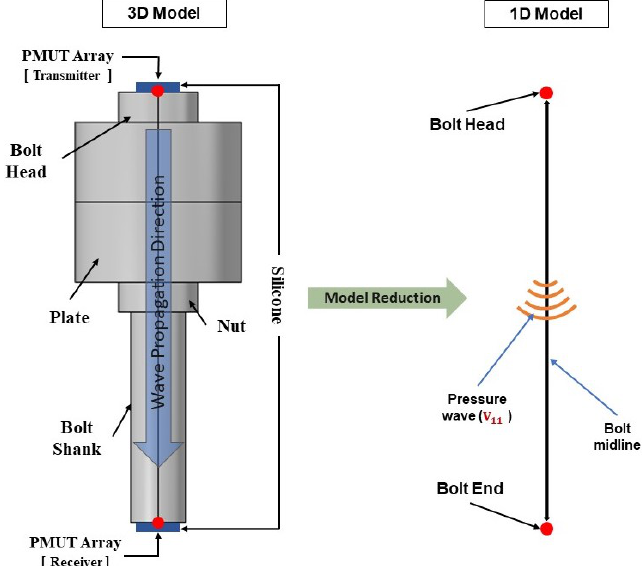
Figure 1. The 3D elastic wave propagation problem can be reduced to a 1D problem based on the fact that both the TOF and CTOF are computed by monitoring only the pressure wave velocity V 11 which is a function of the static stress T 11 only, computed along the bolt axis. The bolt axis represents the shortest distance between the mid point on the surface of the bolt head and the bolt end where the arrays are